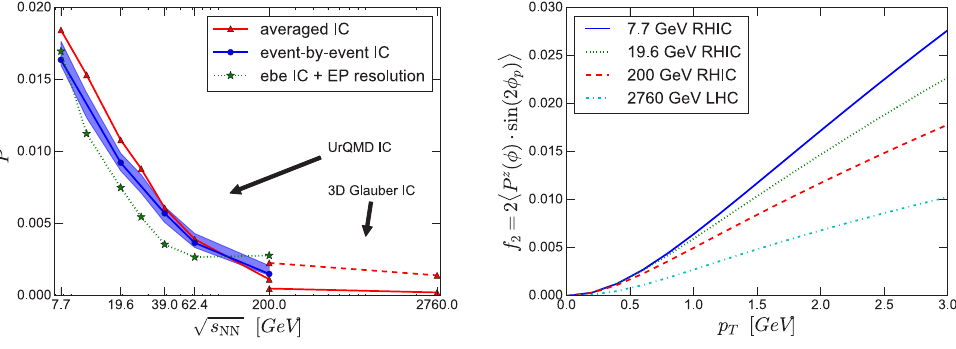
Figure 1. Left panel: collision energy dependence of global Λ polarization along global angular momentum of the fireball, calculated with averaged initial state from UrQMD ( √ s NN = 7.7,...,200 GeV) and Monte Carlo Glauber ( √ s NN = 200,2760 GeV). Right panel: second order Fourier harmonic coe ffi cient of polarization com- ponent along beam direction, calculated as a function of p T for di ff erent collision energies; 200 and 2760 GeV points correspond to Monte Carlo Glauber initial